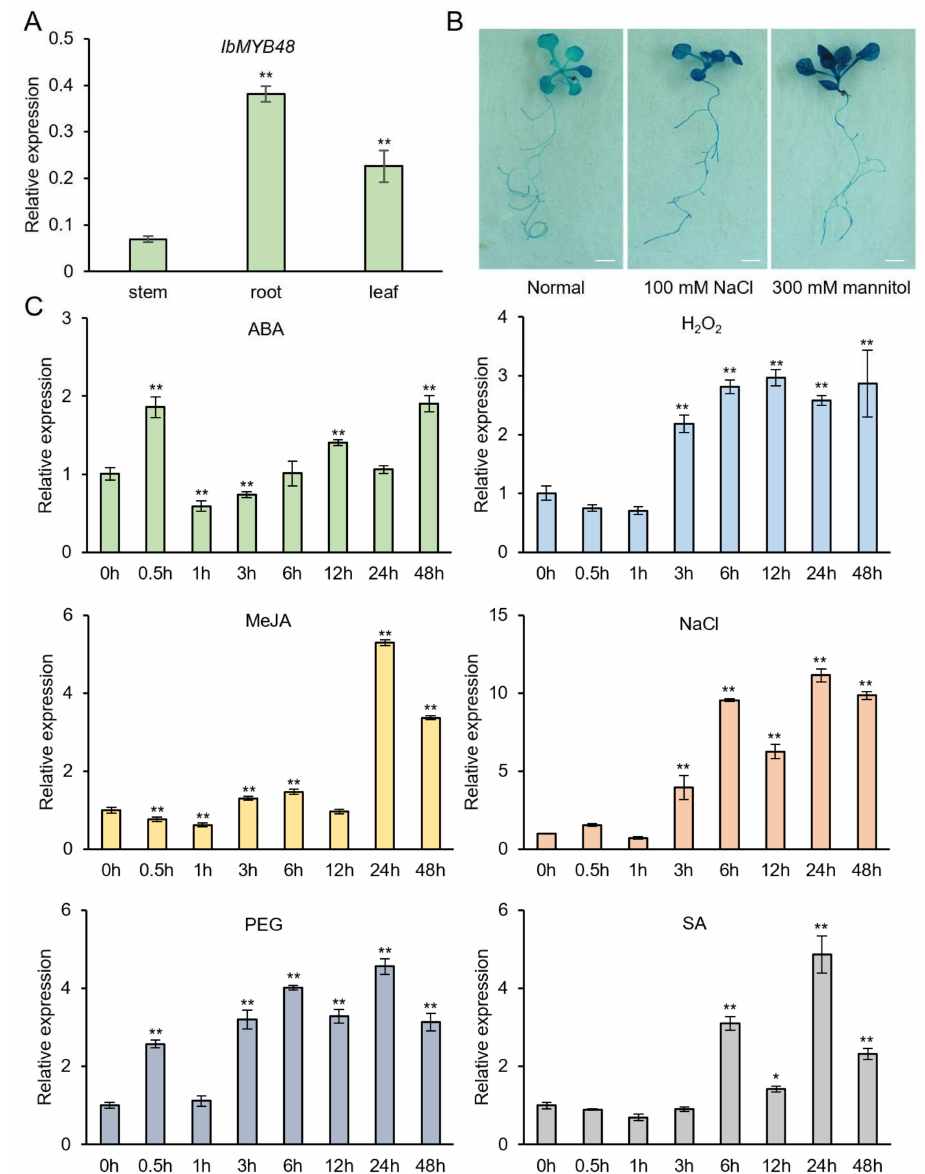
Figure 2. Expression analysis of IbMYB48 . ( A ) Tissue-specific expression of IbMYB48 in the stem, root, and leaf of JS6-5 plants. ( B ) Histochemical staining of GUS activity in IbMYB48pro::GUS transgenic Arabidopsis plants subjected to salt stress. Bars = 3 mm. ( C ) Expression analysis of IbMYB48 in whole plants of JS6-5 in response to 100 µ M ABA, 10 mM H 2 O 2 , 100 µ M MeJA, 200 mM NaCl, 20% PEG6000 and 100 µ M SA, respectively. The IbActin was used as the reference. Error bars reflect ± SE scores ( n = 3); Asterisk (*) and (**) indicate a significant difference at the level p < 0.05, p < 0.01,